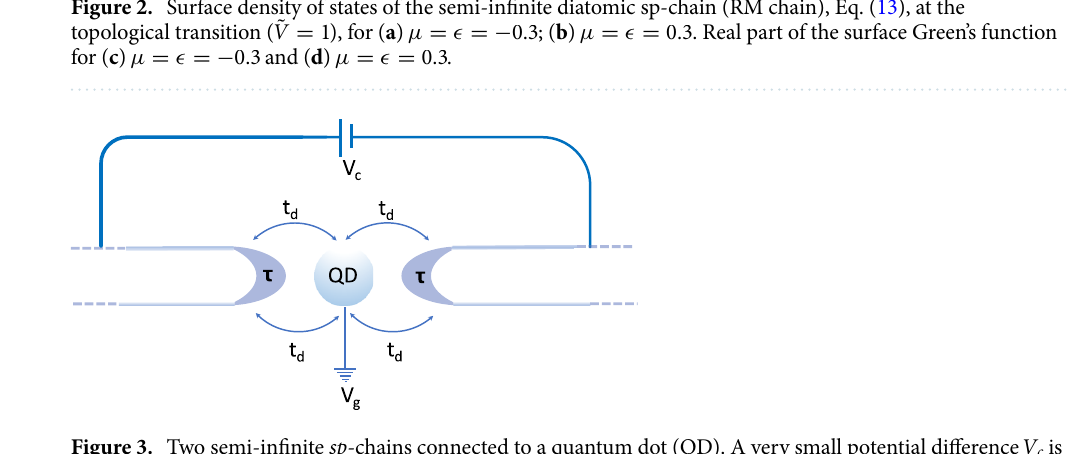
Figure 3. Two semi-infinite sp -chains connected to a quantum dot (QD). A very small potential difference V c is applied in the chains. Notice that t d is the coupling between the dot and the